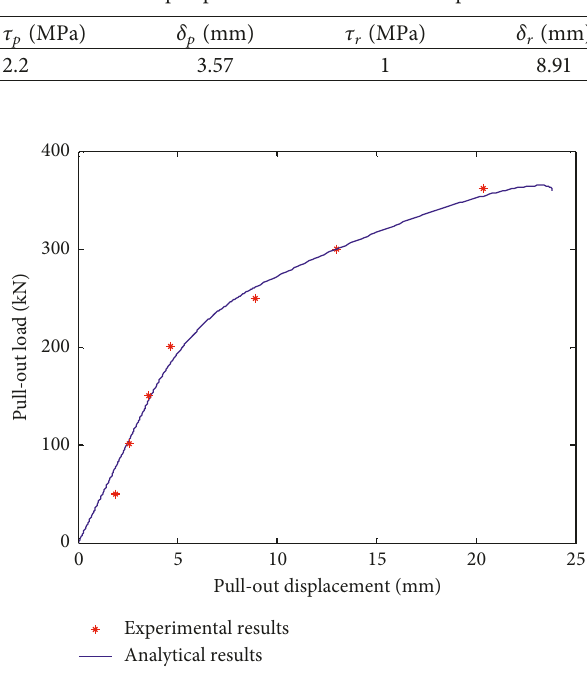
Table 2: Input parameters for the bond-slip model.